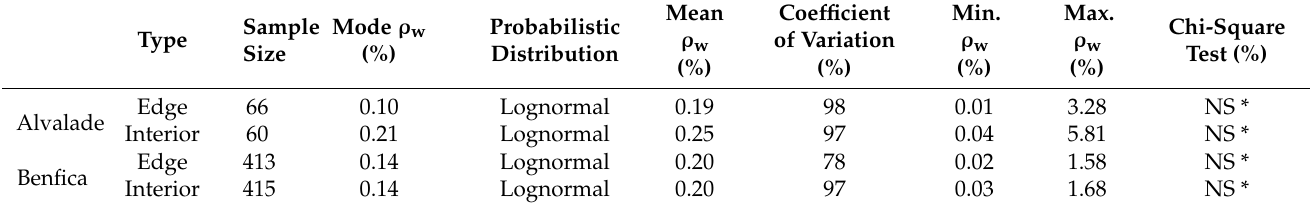
Table 14. Probabilistic distribution of RC beams (cid:48) transverse reinforcement ratio for each parish.